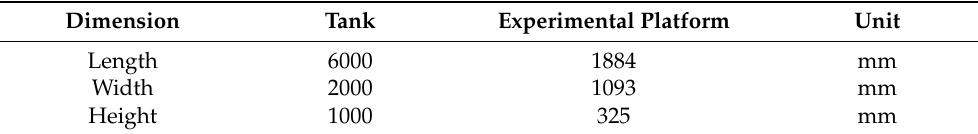
Table 10. The dimensions of the tank and experimental platform.